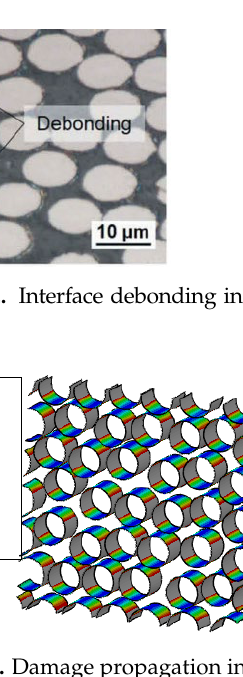
Figure 31. Failure indices and traction force states for the interface. ( a ) failure indices; ( b ) normal traction; ( c ) longitudinal shear traction.